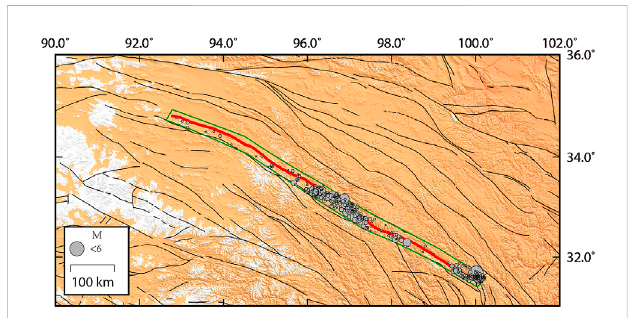
Distribution range of small earthquakes in fault slip rate map. the range of the green box in Figure is approximately 10 km on each side of the fault, the grey circles is an earthquake with magnitude less than